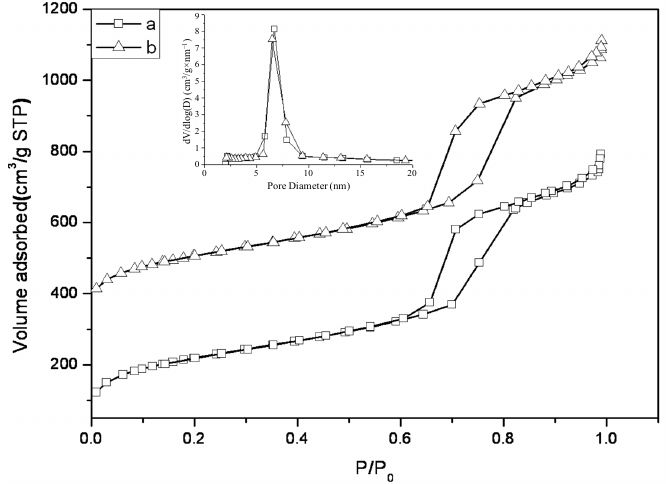
Figure 2. N adsorption–desorption isotherms and pore distribution curves of SBA-15. 2 a: SBA-15-c; b: SBA-15-ex.